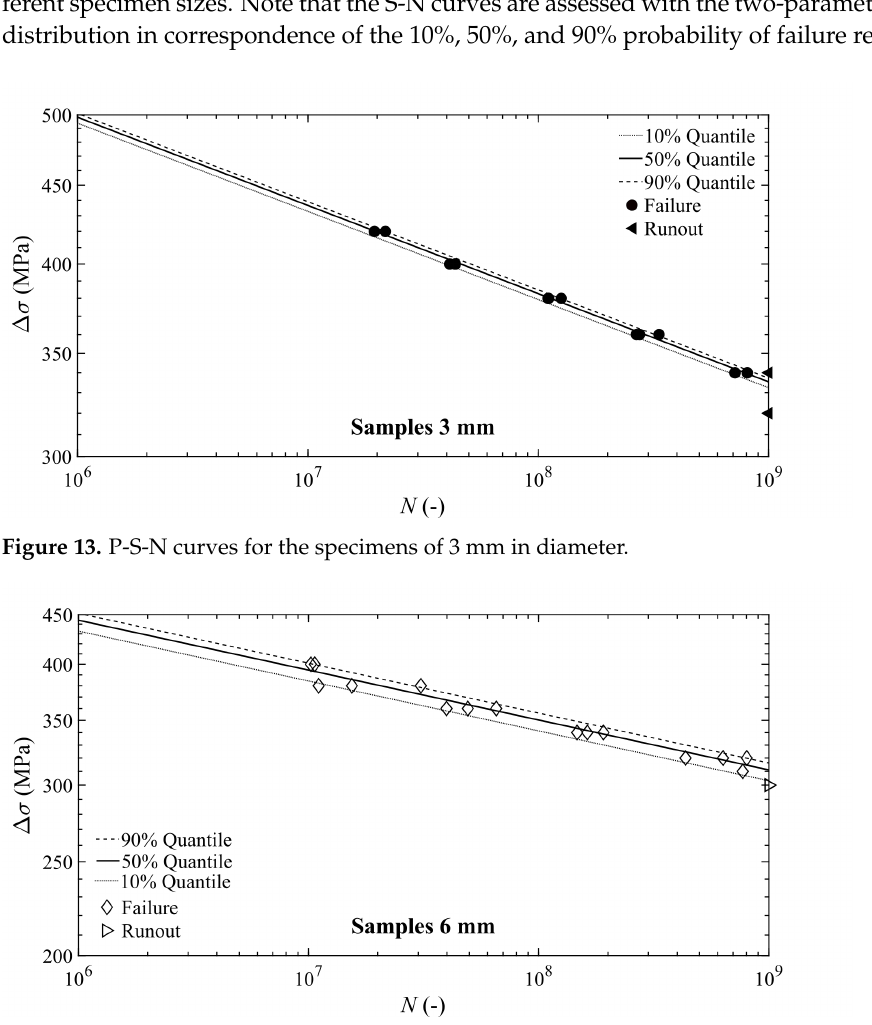
Figure 14. P-S-N curves for the specimens of 6 mm in